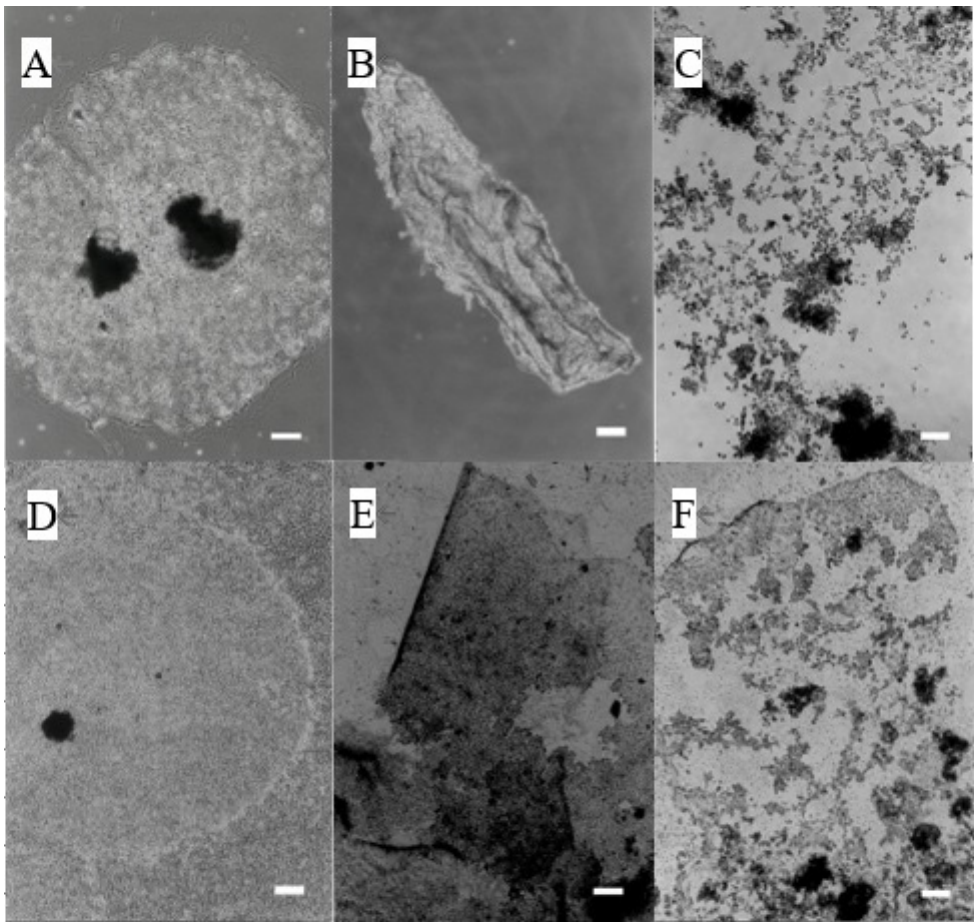
Figure 2. Induction of exfoliation of the trophoblast colony without (A-C) or with (D-F) feeder cells (fibroblasts derived from the placentome) by 12-KETE addition. (A, D) Control, (B) +40 μM of 12-KETE (2.5 h after addition), (E) +40 μM of 12-KETE (5 h after addition), (C) +4 μM of 12-KETE (8 h after addition), (F) +10 μM of 12-KETE (38 h after addition), (white bars: 200 μm). Replications (n≥10) of experiments showed the same results. 12-KETE, 12-oxo-5Z,8Z,10E,14Z-eicosatetraenoic acid.